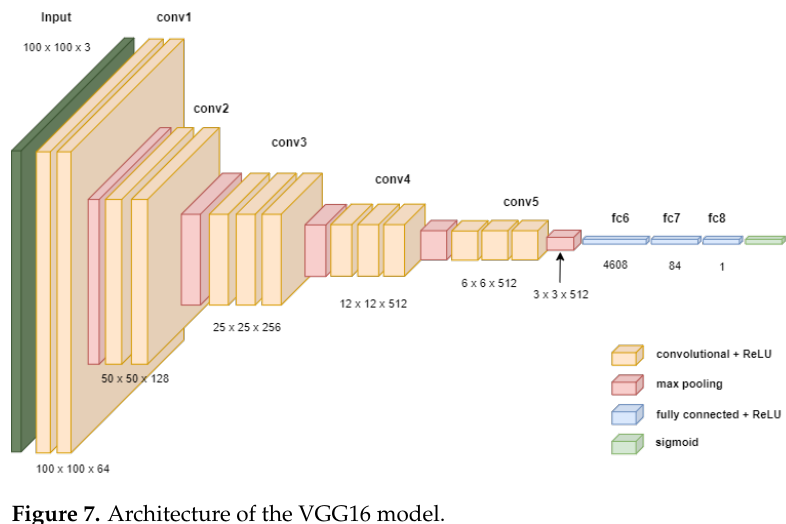
Figure 7. Architecture of the VGG16 model.